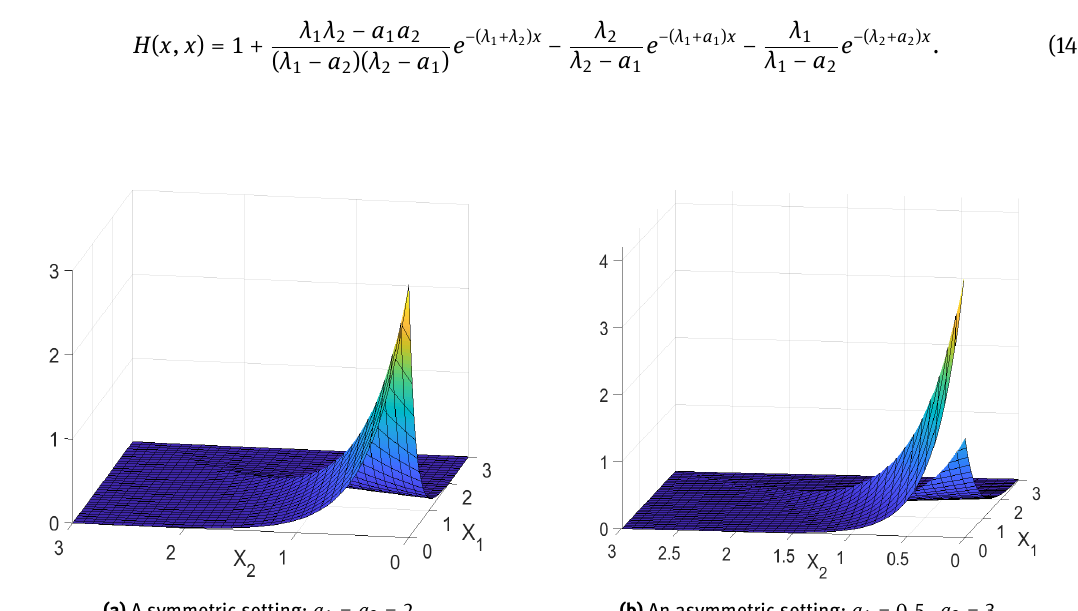
Figure 1: Joint density of ( X 1 , X 2 ) for two different parameter